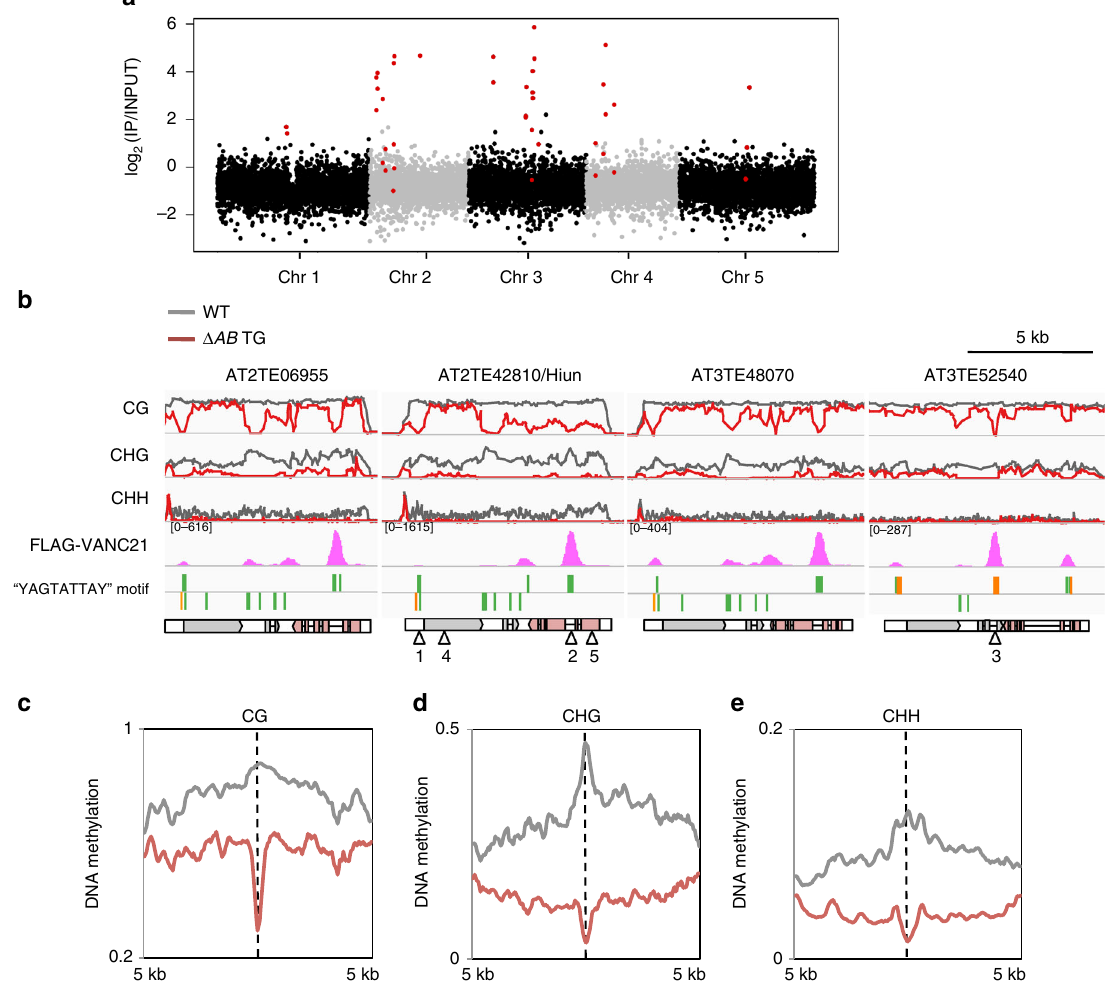
Fig. 2 Genomic localization of the VANC21 protein. a A genome-wide view showing the enrichment of FLAG-VANC21 signal. Each dot represents signal in a 10 kb region. Red dots indicate the regions with VANDAL21 copies more than 1 kb long. b Genome browser views showing the FLAG-VANC21 signals with normalized coverages (per million mapped reads) and DNA methylation pro fi les (0 – 100%) of WT and Δ AB transgenic plants at VANDAL21 copies. Each point represents proportion of methylated cytosine counted within fi ve successive cytosine residues. VANC21 exons are colored red. Arrowheads indicate probe sites used in EMSA (Fig. 3). c – e Three contexts of DNA methylation level around VANC21 biding loci. Around the summits of VANC21-binding loci within VANDAL21 ( N = 89), 500 bp-binned averages of DNA methylation pro fi les were plotted for WT and Δ AB transgenic plants with steps of 50